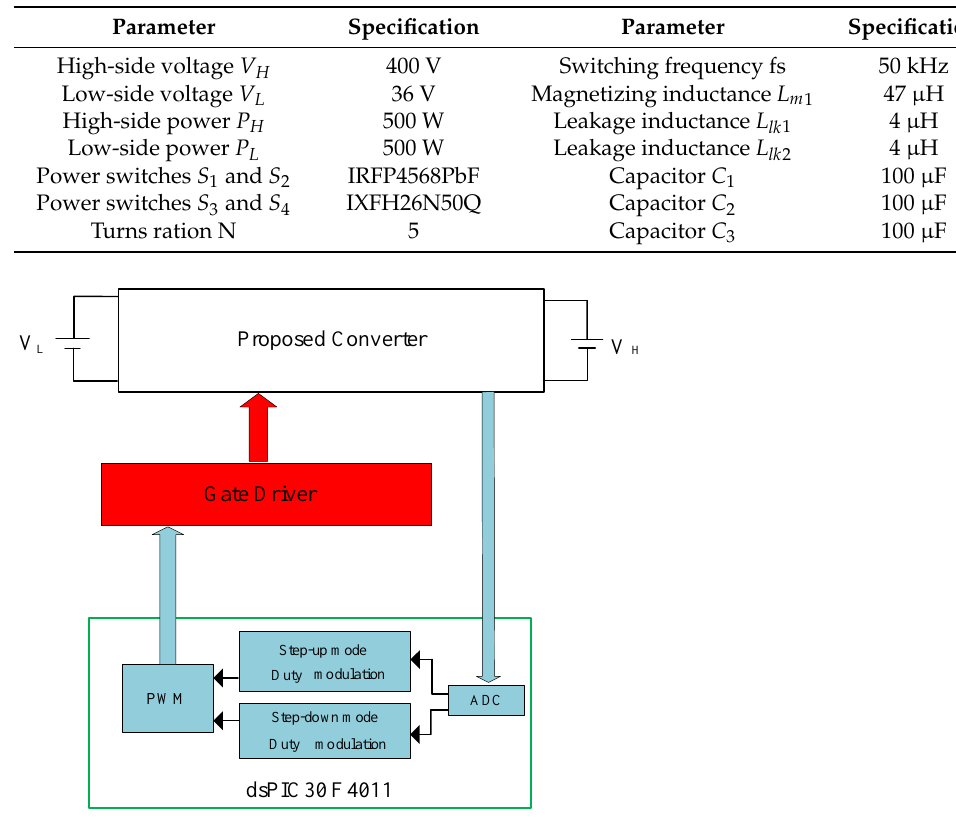
Table 1. Electrical specifications and component parameters of the proposed converter.